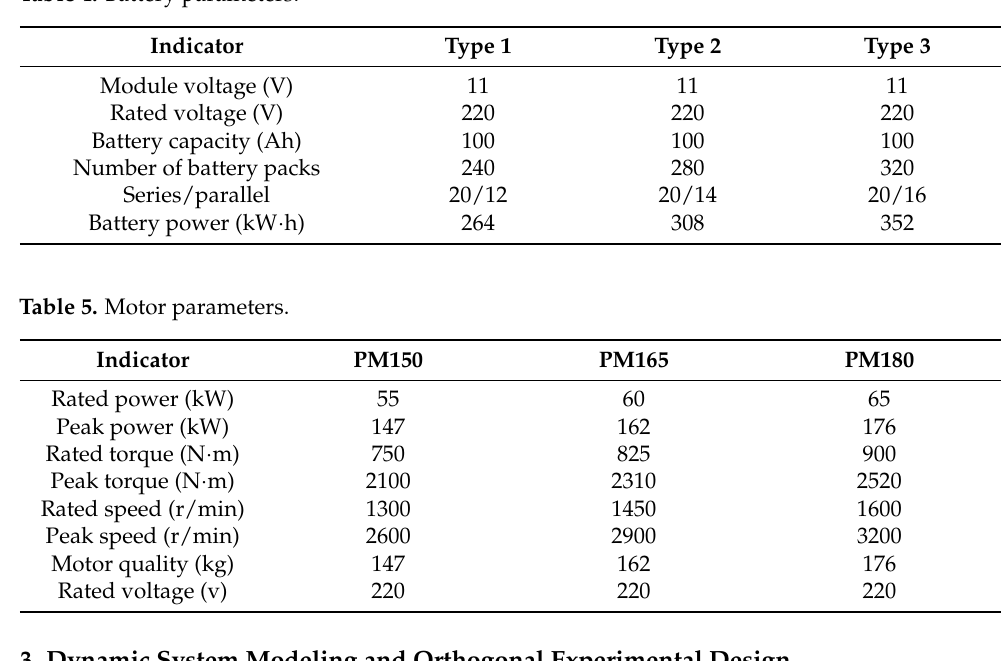
Table 4. Battery parameters.